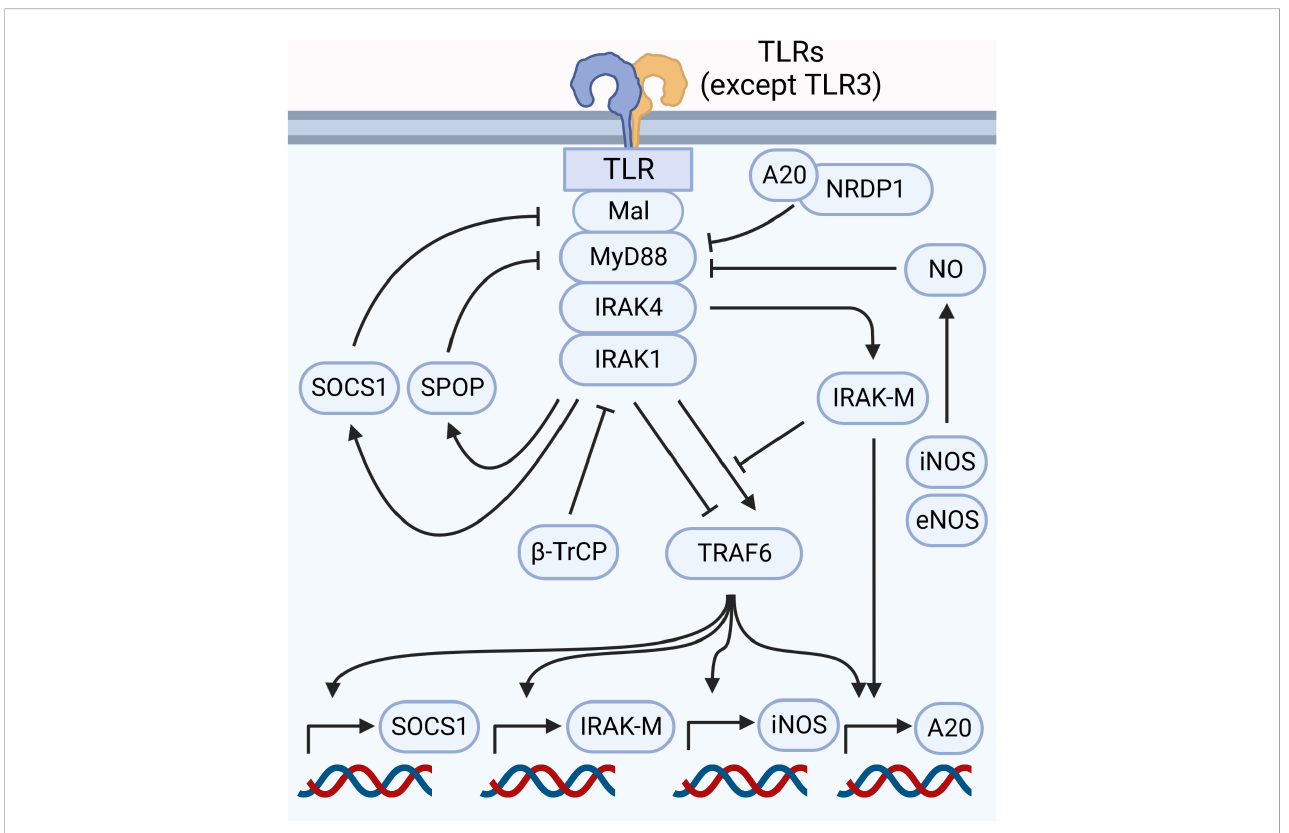
FIGURE 5 Myddosome signaling is regulated at nearly every step. Signaling through the myddosome leads to transcription of negative regulators such as SOCS1, iNOS, IRAK-M and A20. Proteasomal degradation of components such as Mal (controlled by SOCS1), MyD88 (controlled by A20 and NRDP1, in addition to SPOP in HSC), IRAK1 (controlled by b -TrCP), and TRAF6 (triggered by IRAK1) are likely involved in myddosome disassembly and signal termination. IRAK-M antagonizes the myddosome by inhibiting the binding between IRAK1 and TRAF6, besides stimulating A20 expression. Production of NO by eNOS and iNOS leads to S-Nitrosylation of MyD88, inhibiting signal